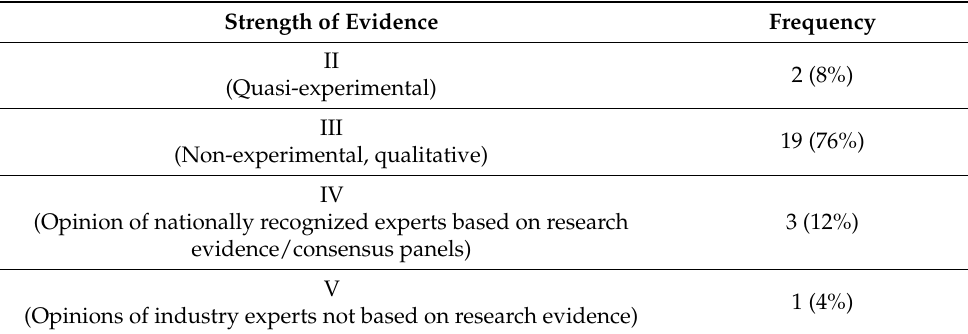
Table 3. Summary of Quality Assessments.